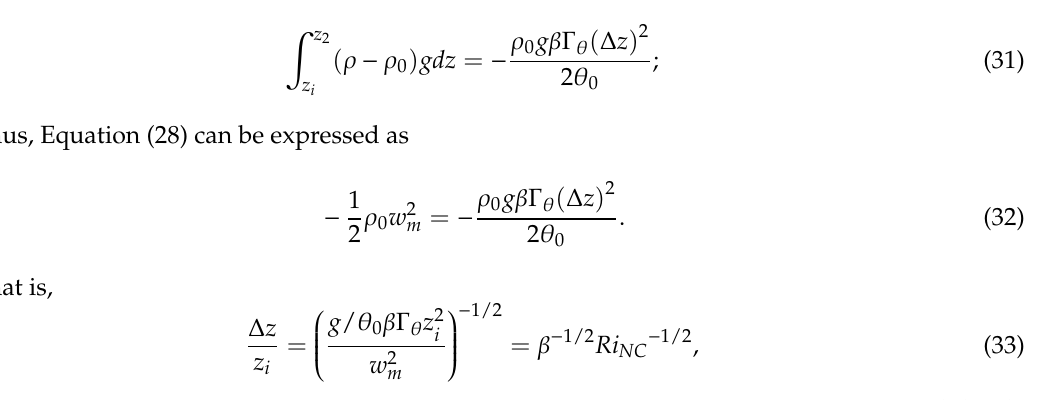
Figure 5. The average distance from discrete points to the line provided by the models in Figures 3 and 4. 5. Conclusions In this study, LES was carried out to simulate the sheared CBL cases in a horizontally homogeneous atmospheric domain. The behaviors of the nine current bulk scaling models between the dimensionless entrainment zone thicknesses and different Richardson numbers (